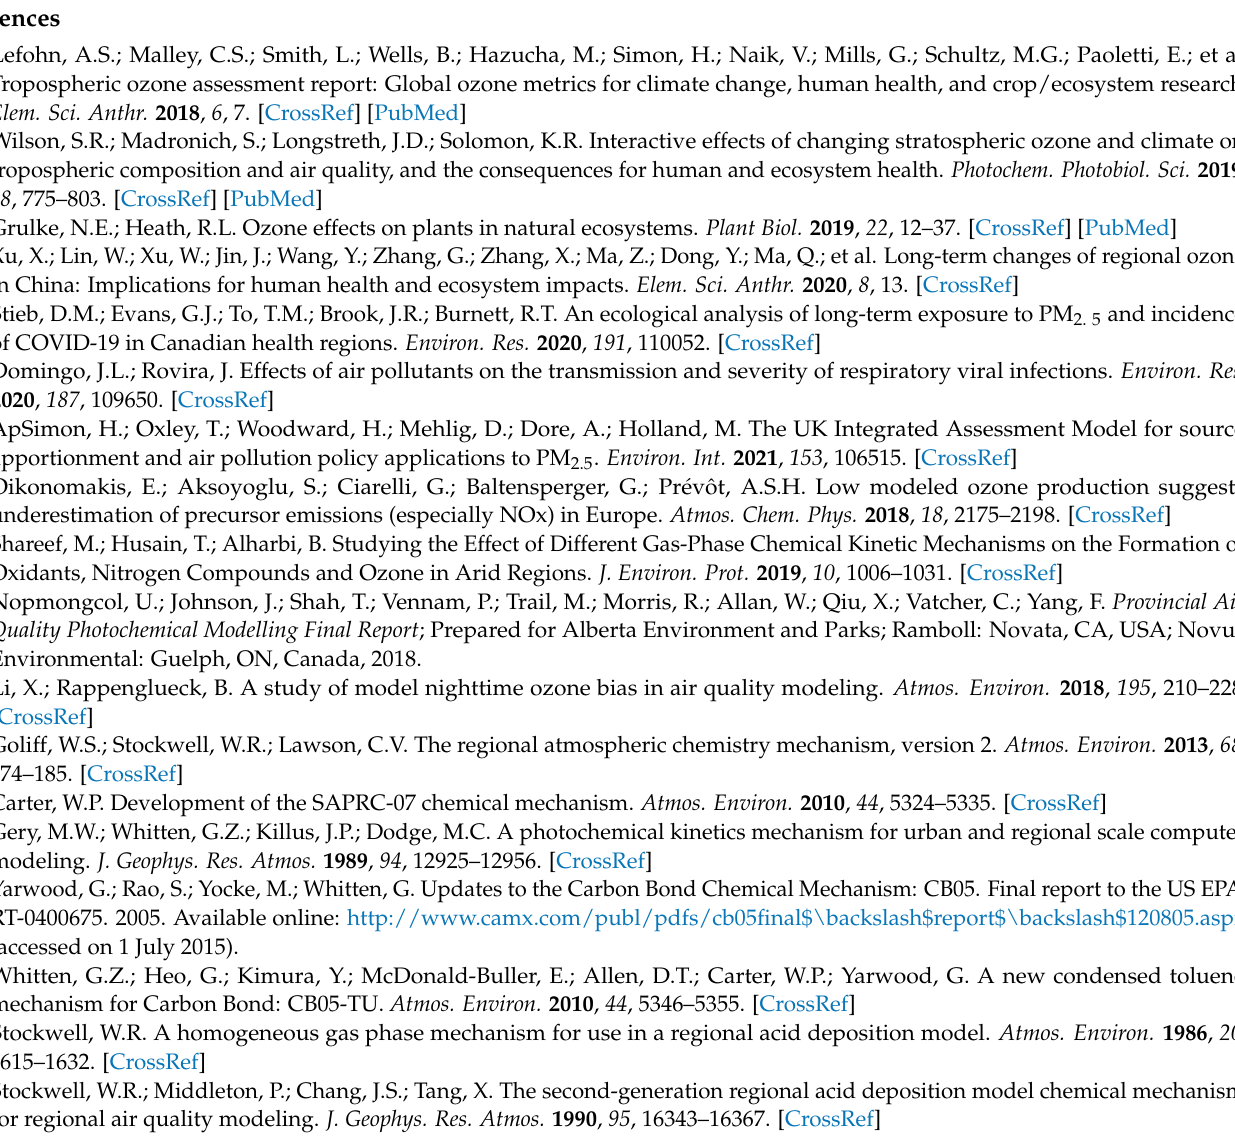
Table S1: CAAQS Management Levels; Table S2: Model Species and their